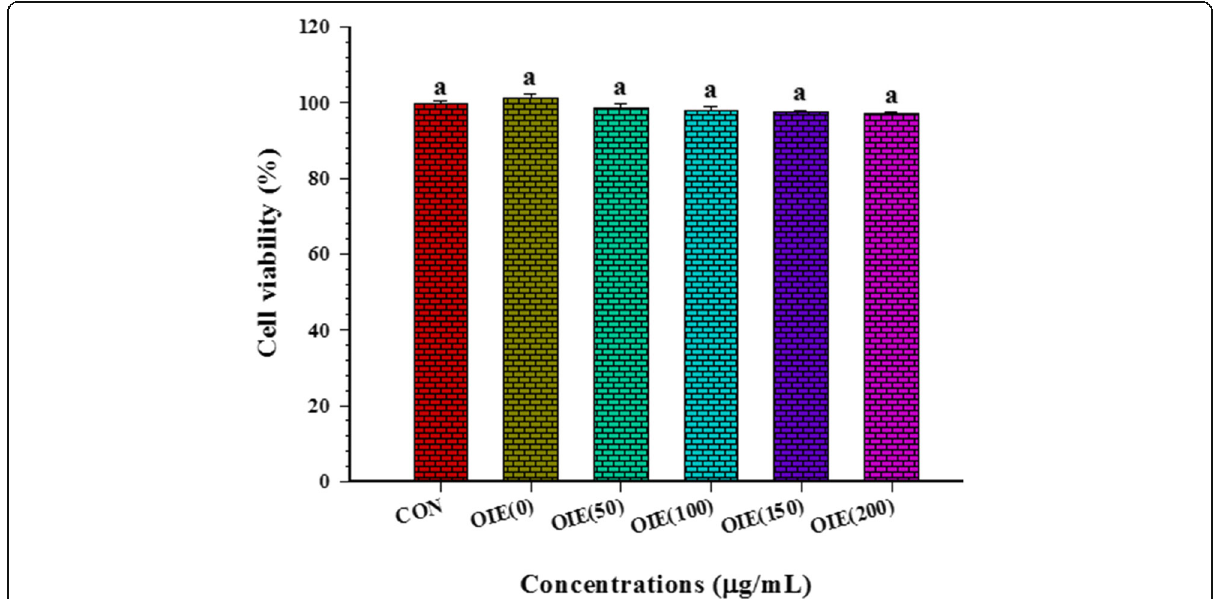
Fig. 2 Graphically represents the effect of Oroxylum indicum extract on the viability of 3T3-L1 mature adipocytes. CON = vehicle control; OIE(50) = Oroxylum indicum at 50 μ g/mL. Values are Means ± SEM ( n = 3 replicates). For all treatments no significant differences were observed (Tukey ’ s HSD test, p < 0.05)